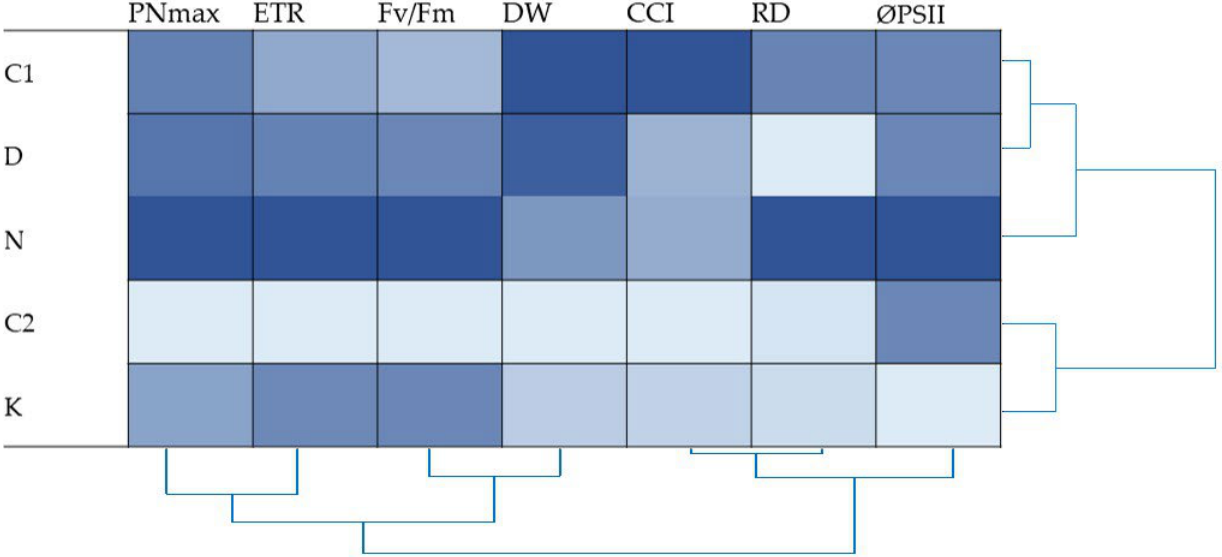
Figure 4. Effects of phytostimulators on maximum net photosynthetic rate (P N max), maximum photosynthetic efficiency of PS II (Fv/Fm), electron transport rate (ETR), chlorophyll content index (CCI), dark respiration rate (RD ), effective quantum yield of photosystem II in the light (ΦPSII), dry weight of whole plant (g/plant) (DW) at BBCH 65, control treatment under normal growth conditions without cold stress (C1), second control treatment under stress growth conditions with cold (C2), Kelpak ® (K), Nano Active ® (N), Dynamic Cresco ® (D).